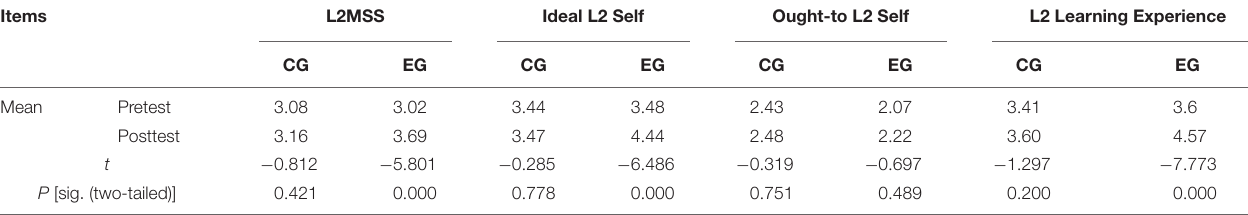
TABLE 2 | L2MSS of the two groups before and after the experiment. Items